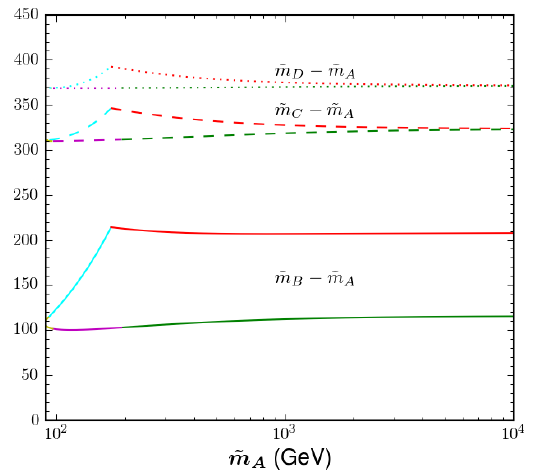
Figure 16 . The analogue of (cid:12)gure 4, but for the (cid:13)at direction de(cid:12)ned in (cid:12)gure 15. previously in ref. [89] as an example of a discrete two-fold ambiguity, while here it serves to de(cid:12)ne a (cid:13)at direction (1.7) in mass parameter space. This (cid:13)at direction is illustrated in (cid:12)gures 15 and 16, which are the analogues of (cid:12)gures 3 and 4, respectively. According